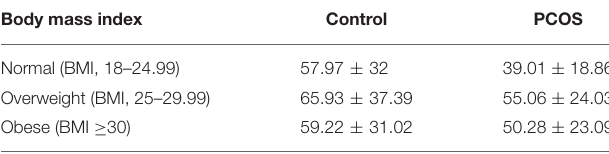
TABLE 2 | Vitamin D level according to body mass index subcategory in patients with PCOS and